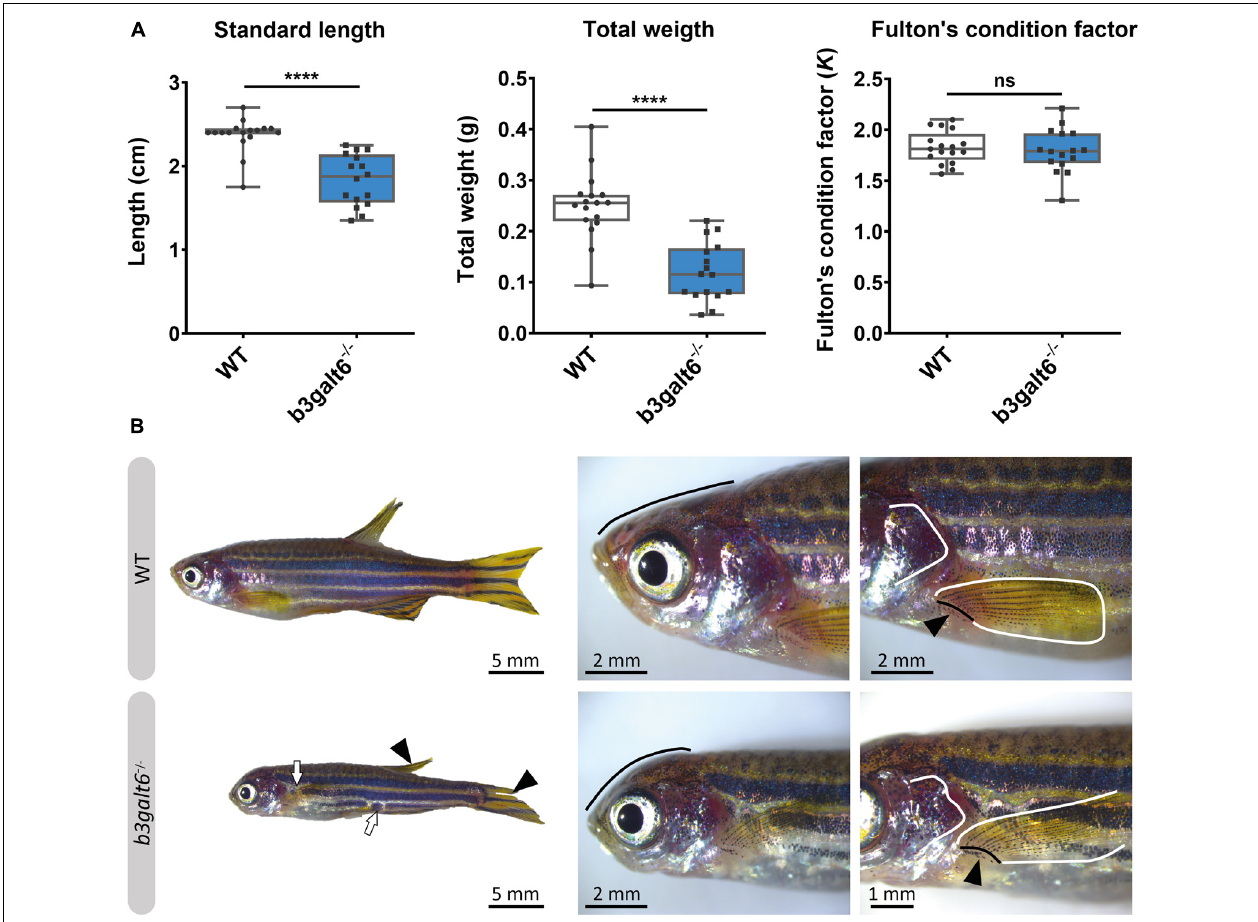
FIGURE 4 | Characterization of the external phenotype of adult b3galt6 − / − zebrafish. (A) b3galt6 − / − zebrafish ( n = 16) had a significantly shorter standard length (SL) compared to their WT siblings ( n = 17). The weight (W) was significantly lower in the mutant zebrafish. The Fulton’s condition factor [ K = 100*(W/SL 3 )] was not significantly different between b3galt6 − / − zebrafish and WT siblings. Data are expressed as box plots with min-to-max whiskers on which each individual data point is plotted. An unpaired t -test with Welch’s correction was used to determine significance. **** P < 0.0001, ns: not significant. (B) Adult b3galt6 − / − zebrafish exhibit morphological abnormalities compared to their WT siblings; b3galt6 − / − zebrafish display interruptions of the blue horizontal stripes (white arrows), smaller fins (arrowhead), aberrations of the head shape (black line), of the shape of the opercular apparatus (white line indicates the posterior edge) and of the pectoral fin (black line and arrow indicate the fin rays at the base of the fin, white line shows the outline of the